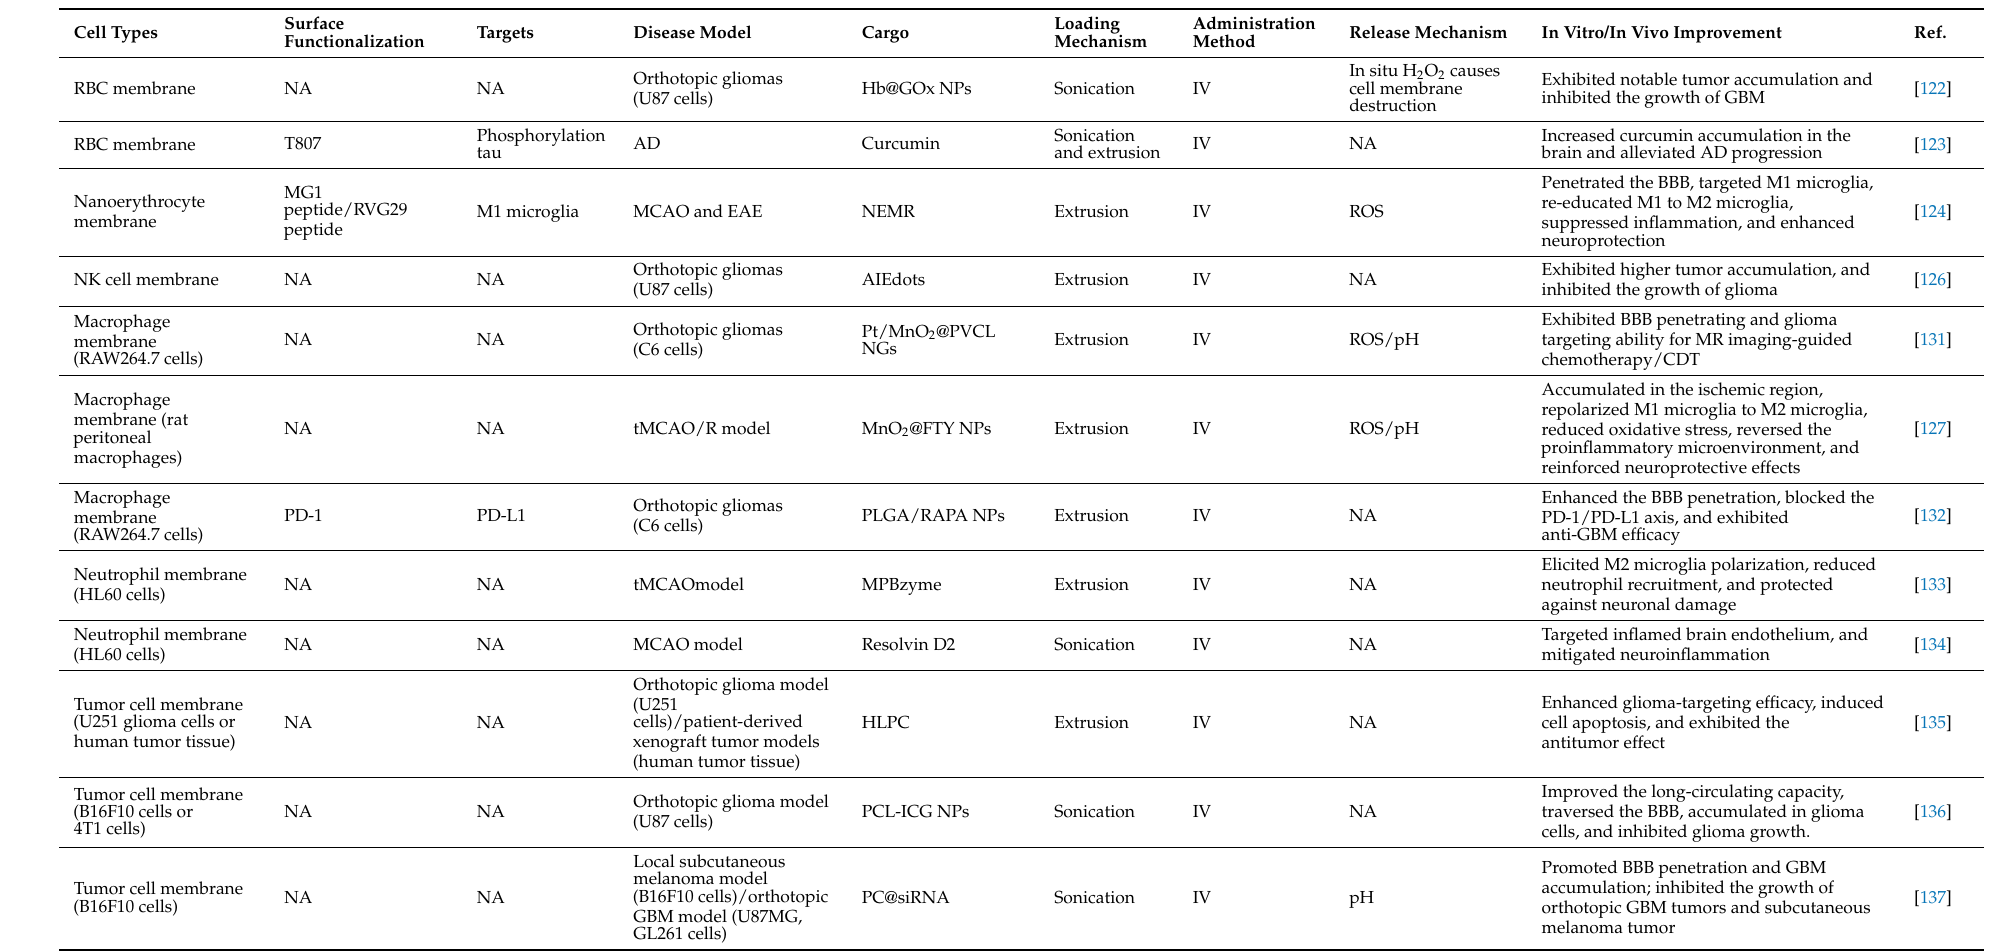
Table 3. Cell membrane-cloaked nanoparticles for BBB-crossing